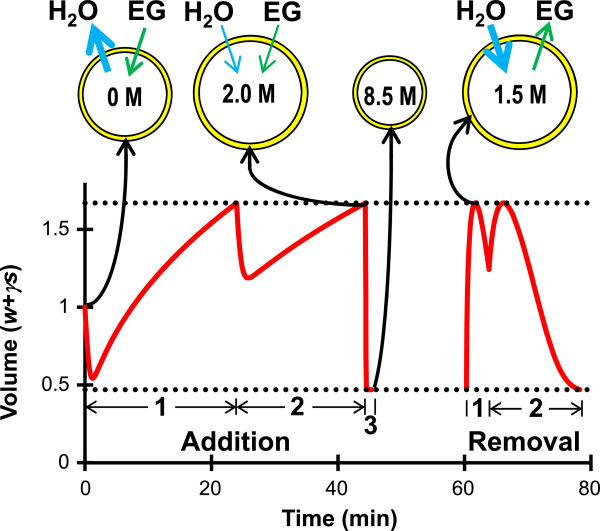
Addition and removal of 8.5 mol/L EG using the methods indicated with asterisks in Table2. The intracellular EG concentration (in mol/L) and transmembrane fluxes of water and EG are illustrated at several points in the CPA addition and removal process. During EG addition, the extracellular EG concentration was equal to 1.3 mol/L, 2.1 mol/L and 8.5 mol/L during steps 1, 2 and 3, respectively. The horizontal dotted lines show the osmotic tolerance limits.